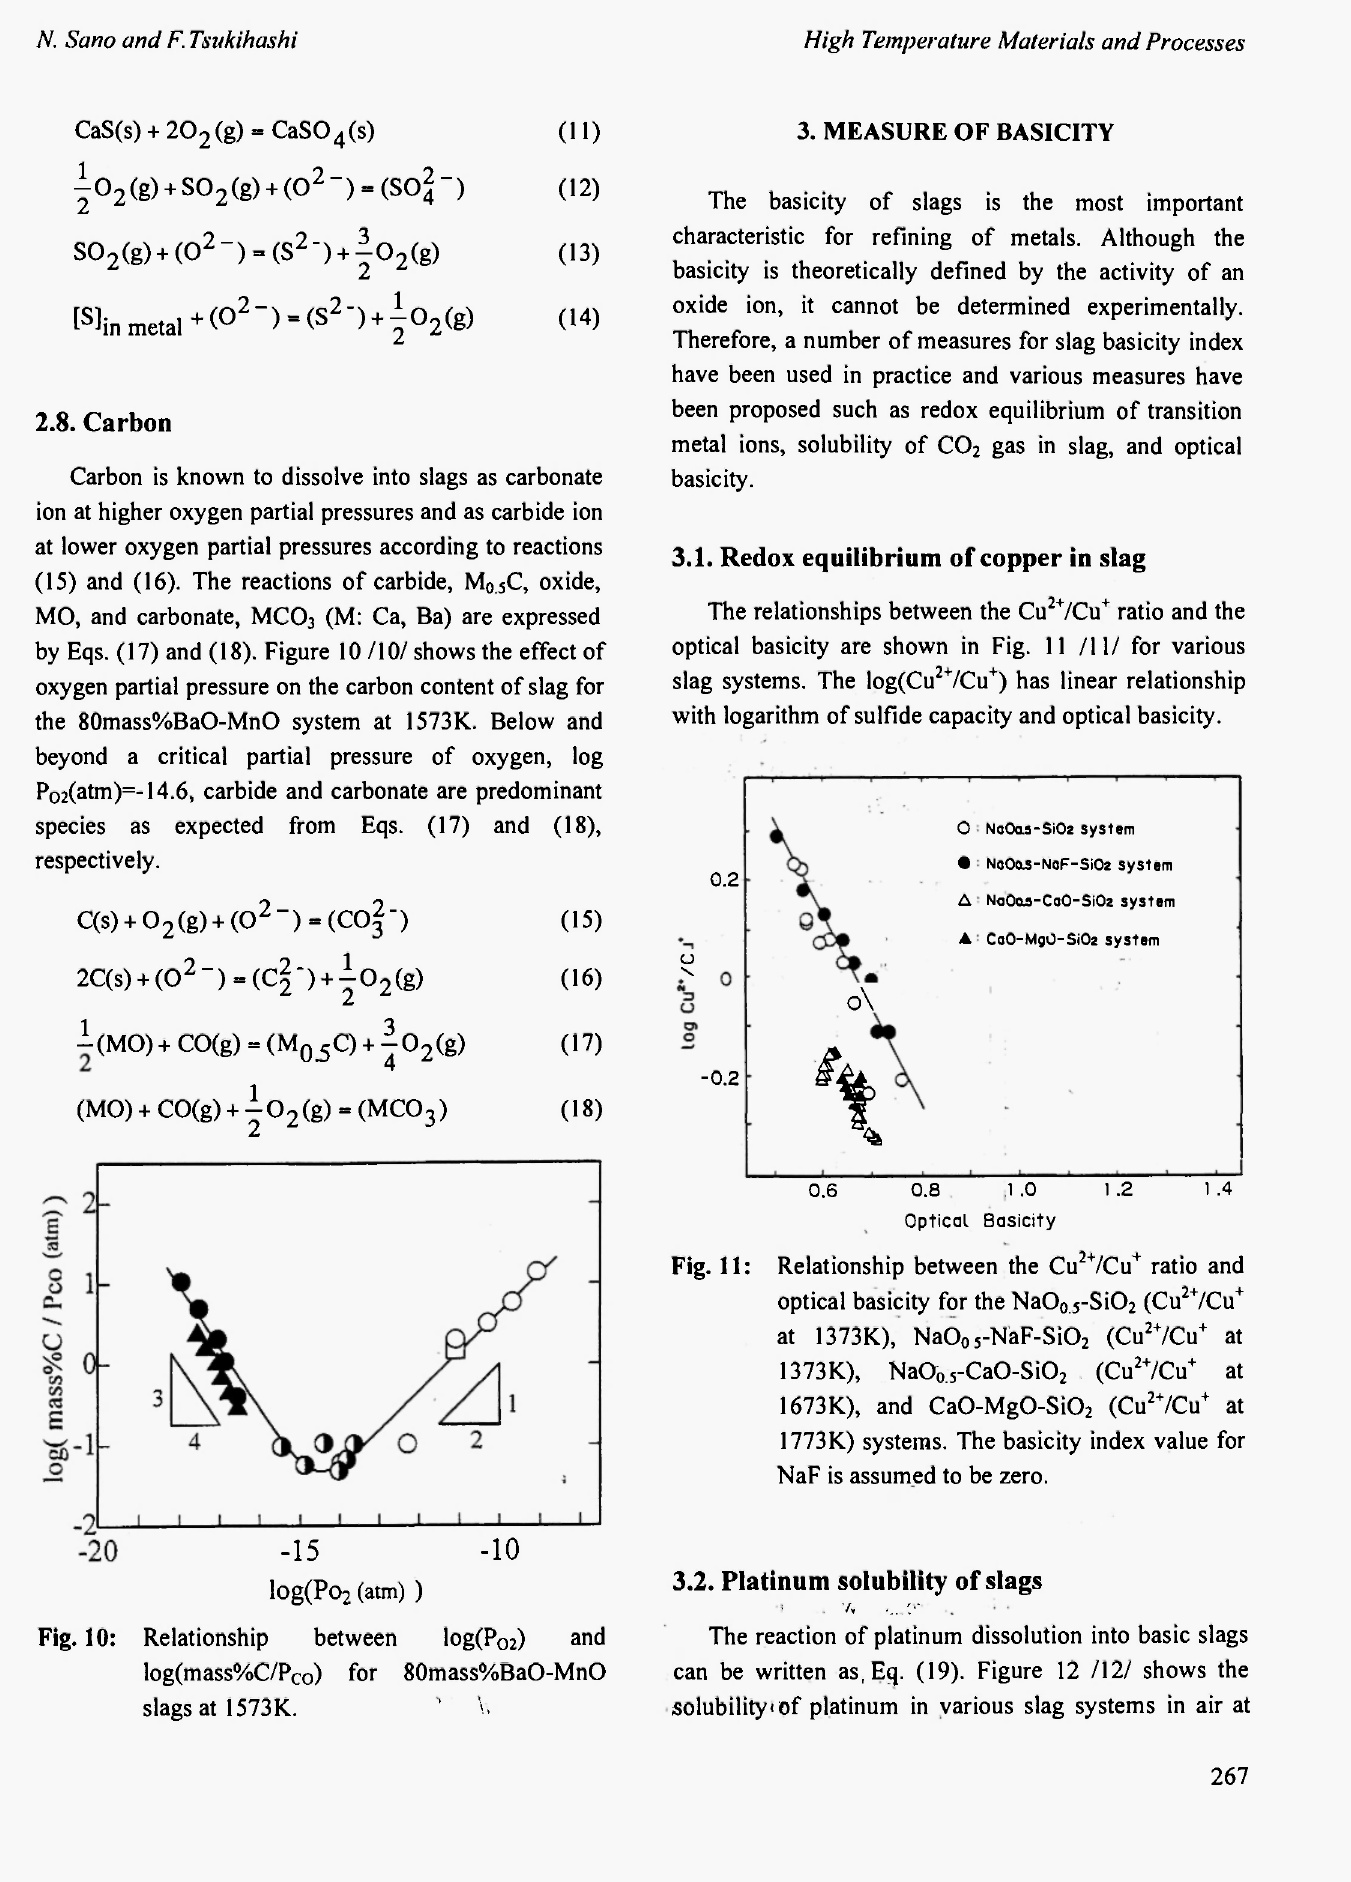
Fig. 10: Relationship between log(Po 2 ) and log(mass%C/P co ) for 80mass%BaO-MnO slags at 1573K. V,